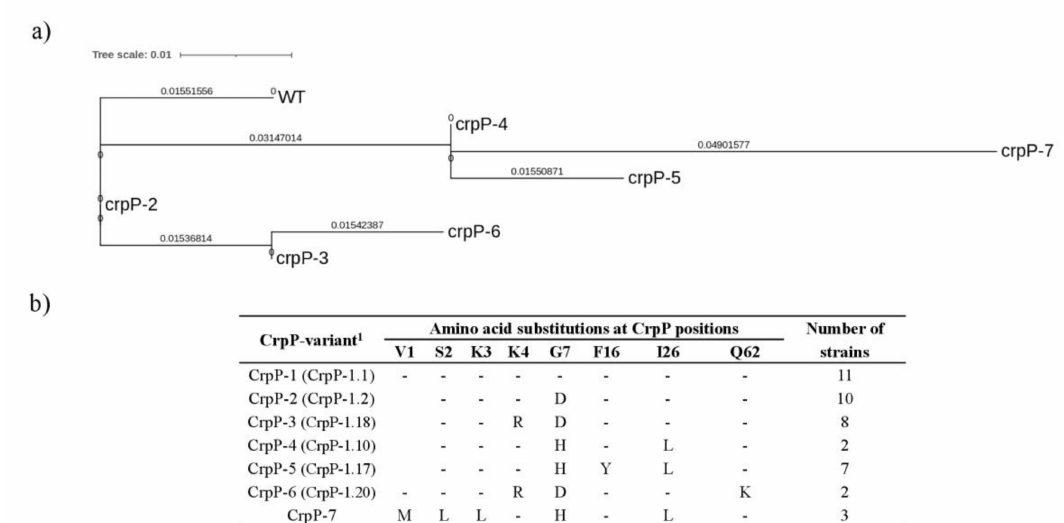
Figure 2. ( a ) Maximum-likelihood phylogenetic tree generated by the alignment of the amino acidic sequences of the CrpP variants found in this study. The alignment and the tree were generated with MEGA11. WT is CrpP-1. ( b ) Amino acid substitutions of each CrpP variant detected in this study compared to the first described CrpP in pUM505 plasmid (named CrpP-1) (GenBank accession number HM560971). 1 The variants included into brackets correspond to the variants previously detected by Zhu et al. (2021) [10]. CrpP-7 is a new variant found only in our